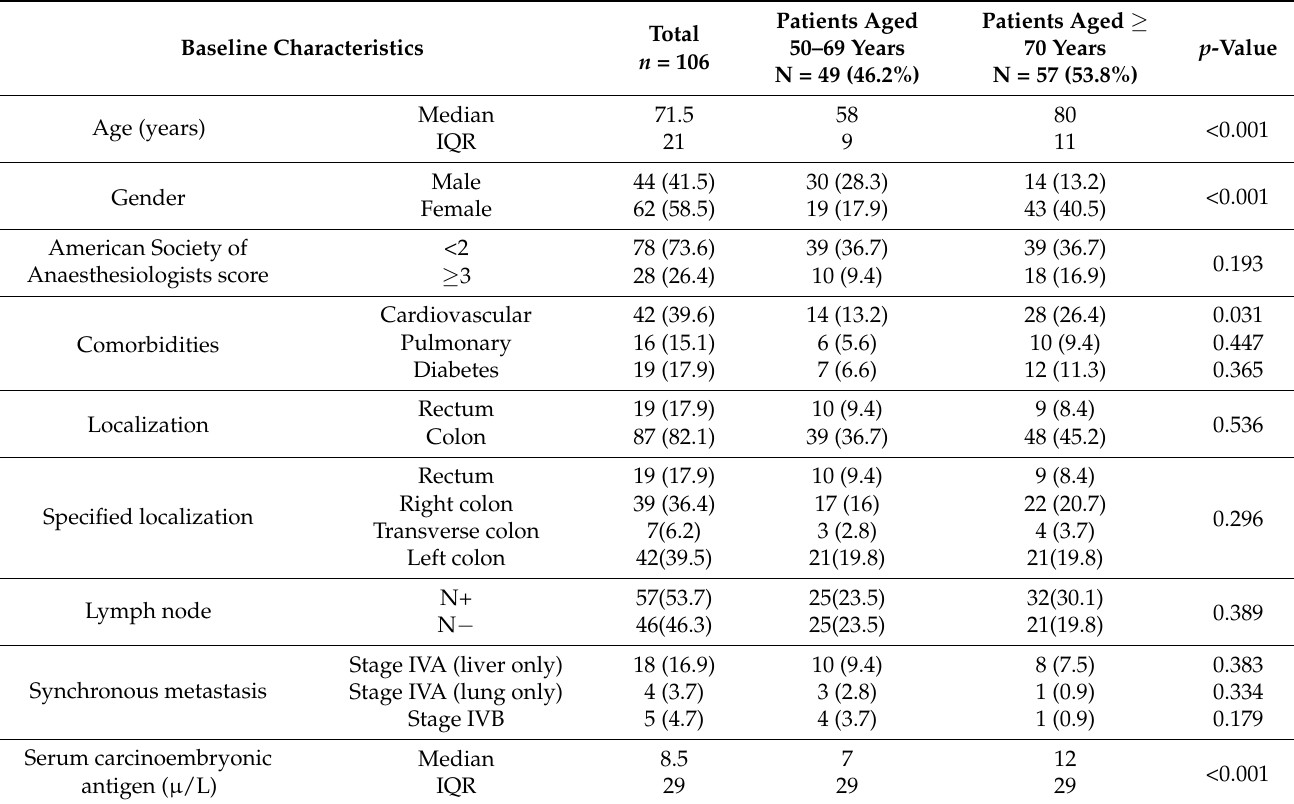
Figure 1. Flowchart of included patients. Table 1. Patients and tumor characteristics